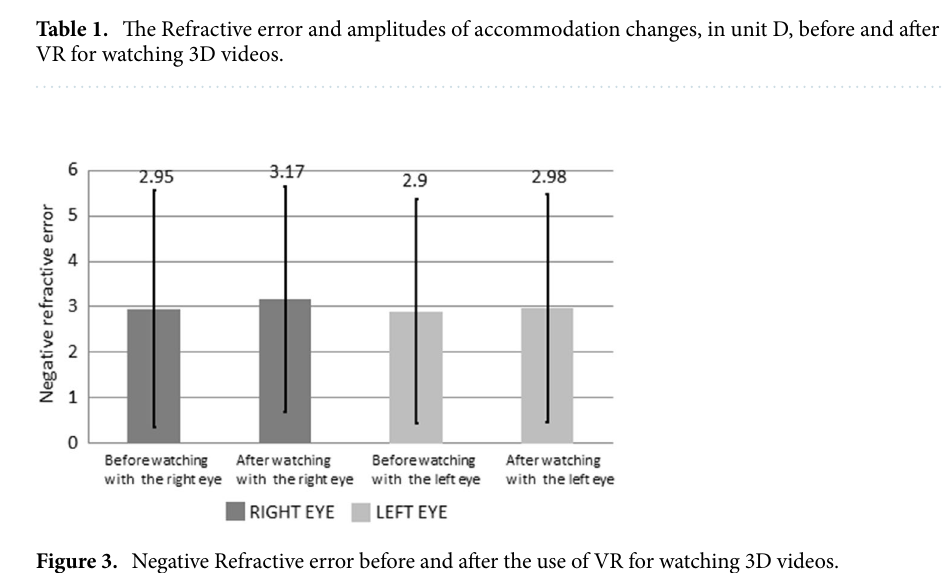
Figure 3. Negative Refractive error before and after the use of VR for watching 3D videos.